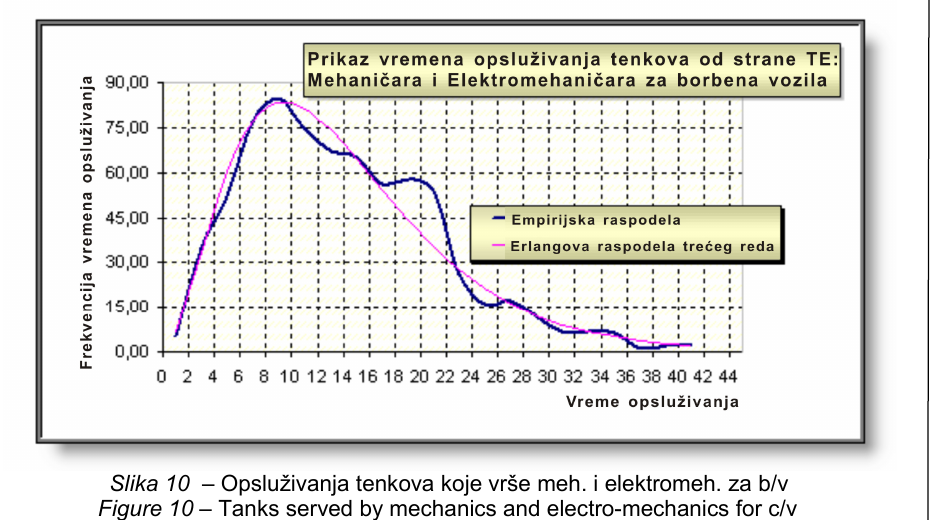
Figure 10 – Tanks served by mechanics and electro-mechanics for